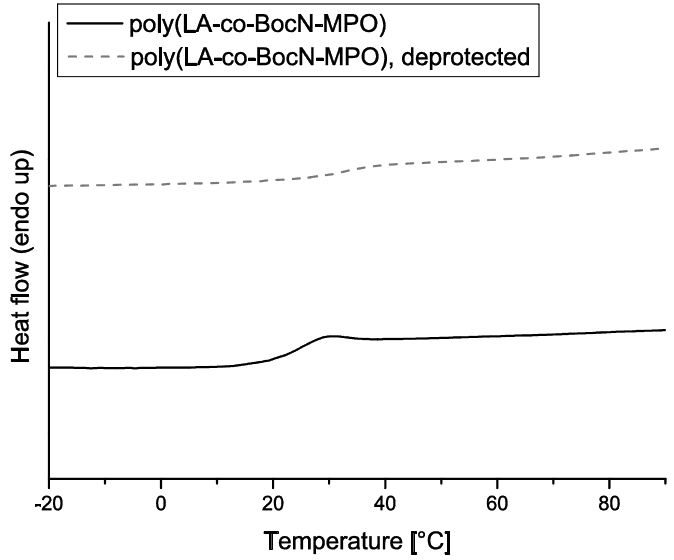
Figure 8. DSC curves for poly(LA-co-BocN-MPO) and deprotected poly(LA-co-BocN-MPO) with a comonomer incorporation of